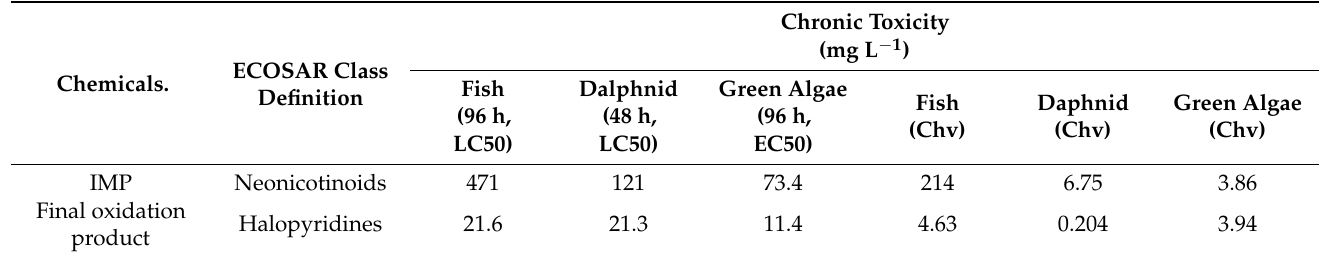
Table 4. Aquatic toxicities resulting from IMP, BS and AZM and the relevant final oxidation product, calculated by ECOSAR